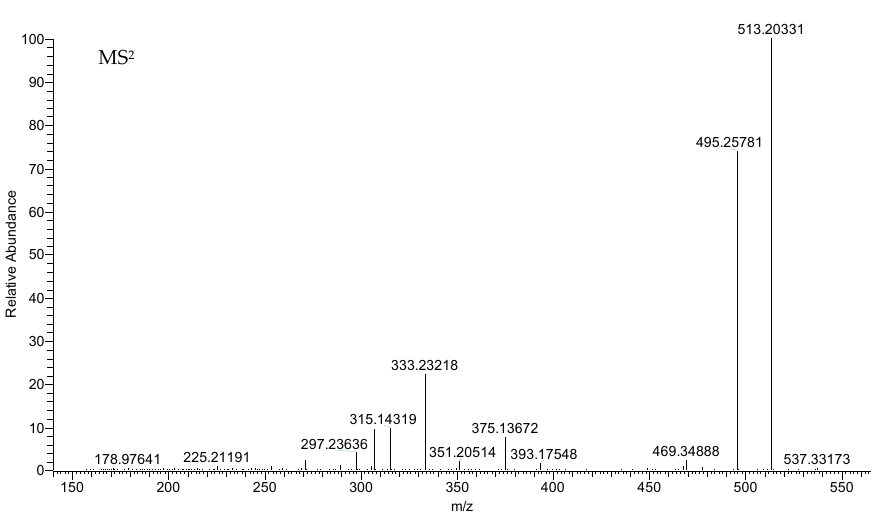
Figure 3. Spectra of ion fragments in MS n analysis of tinosineside A in negative ion mode.